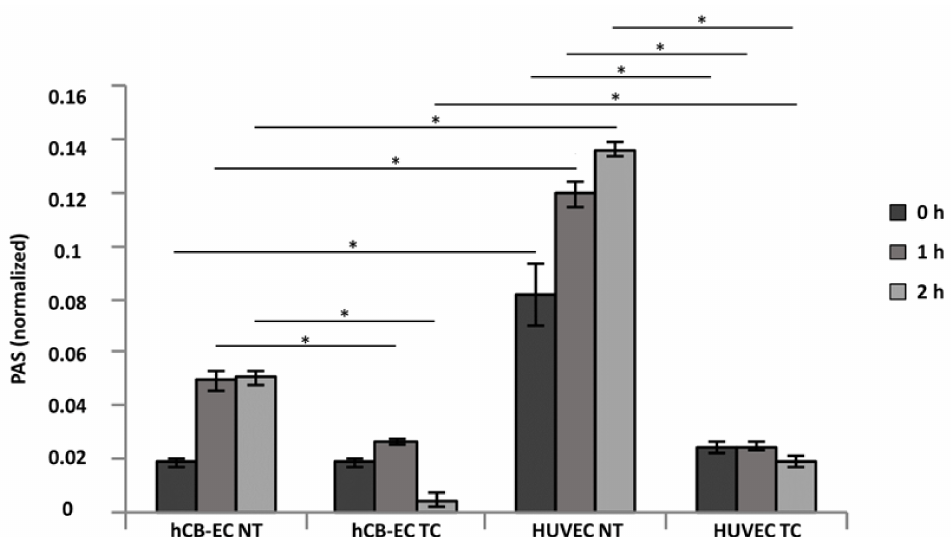
Figure 5. Platelet activity state (PAS) of hCB-EC or HUVEC seeded on thermoformed and coated (TC) scaffolds compared to nontreated (NT) scaffolds at 0, 1, and 2 h. TC groups have lower platelet activation when compared to NT groups; hCB-ECs have lower platelet activation than that of HUVECs (comparisons between hCB-EC and HUVEC cultured in same scaffold and comparisons between NT and TC of same cell type, * p < 0.05, n =